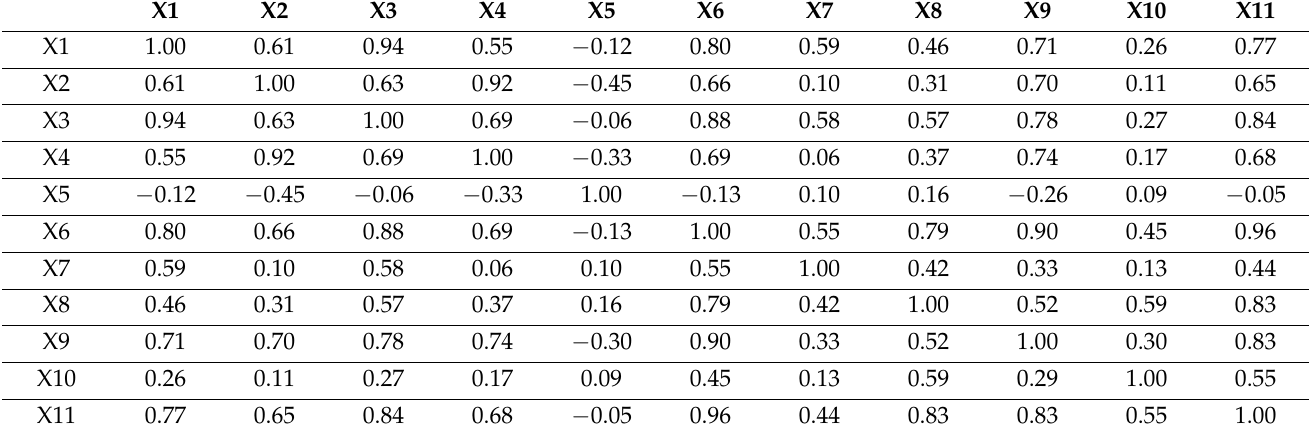
Table 7. Correlation matrix for